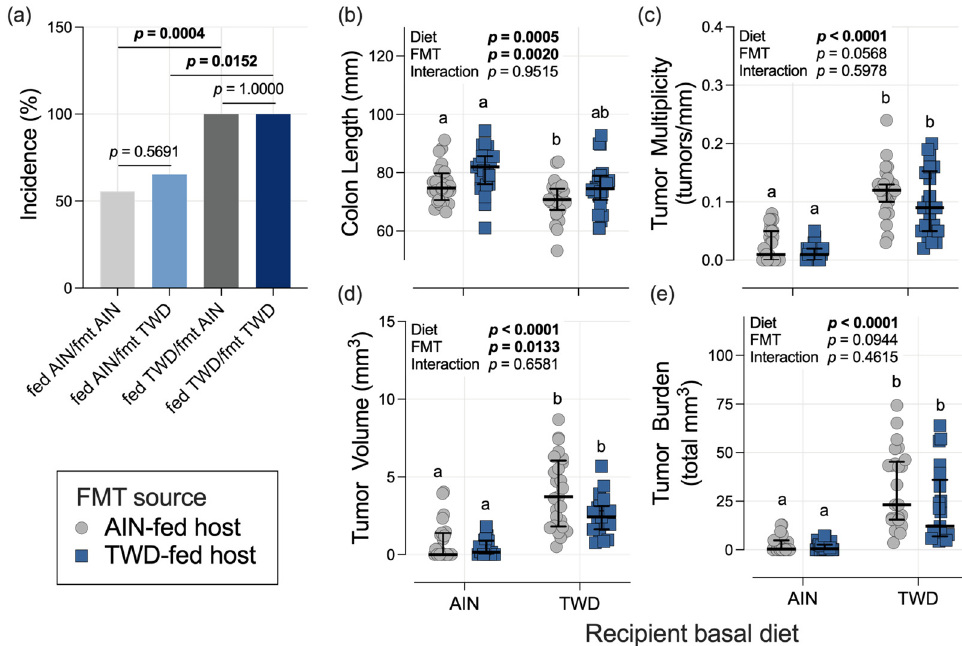
Figure 3. Effect of recipient basal diet and FMT source on colon length and colon tumorigenesis. ( a ) Incidence of colon tumors shown as the percentage of mice with tumors at the terminal time point ( n = 22 to 27 mice per group). p -values from pairwise Fisher’s exact tests (selected a priori) are shown. ( b ) Colon length ( n = 22 to 27 mice per group). ( c ) Colon tumor multiplicity (number of tumors per mm colon length) ( n = 19 to 27 mice per group). ( d ) Average tumor volume ( n = 18 to 25 mice per group). ( e ) Tumor burden (total volume) ( n = 20 to 25 mice per group). For ( b – e ), the data are shown as individual values with median ± interquartile range. The inserted values provide the statistical model’s main effects for recipient basal diet and FMT source, and their interaction, and different letters indicate that the experimental groups are significantly different ( p < 0.05), as determined by the statistical methods outlined in the Materials and Methods section.